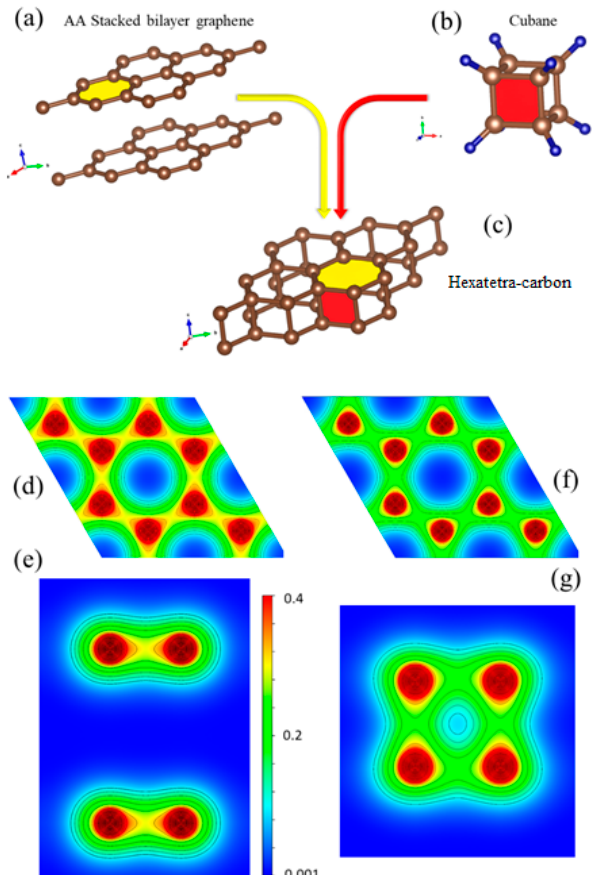
Figure 5. Crystal structure of ( a ) AA-stacked bilayer graphene, ( b ) cubane molecule, and ( c ) hexatetra-carbon ( d , e ). Top and side views of valence charge density distribution for AA-stacked graphene and ( f , g ) for hexatetra-carbon obtained by WIEN2K code [21].